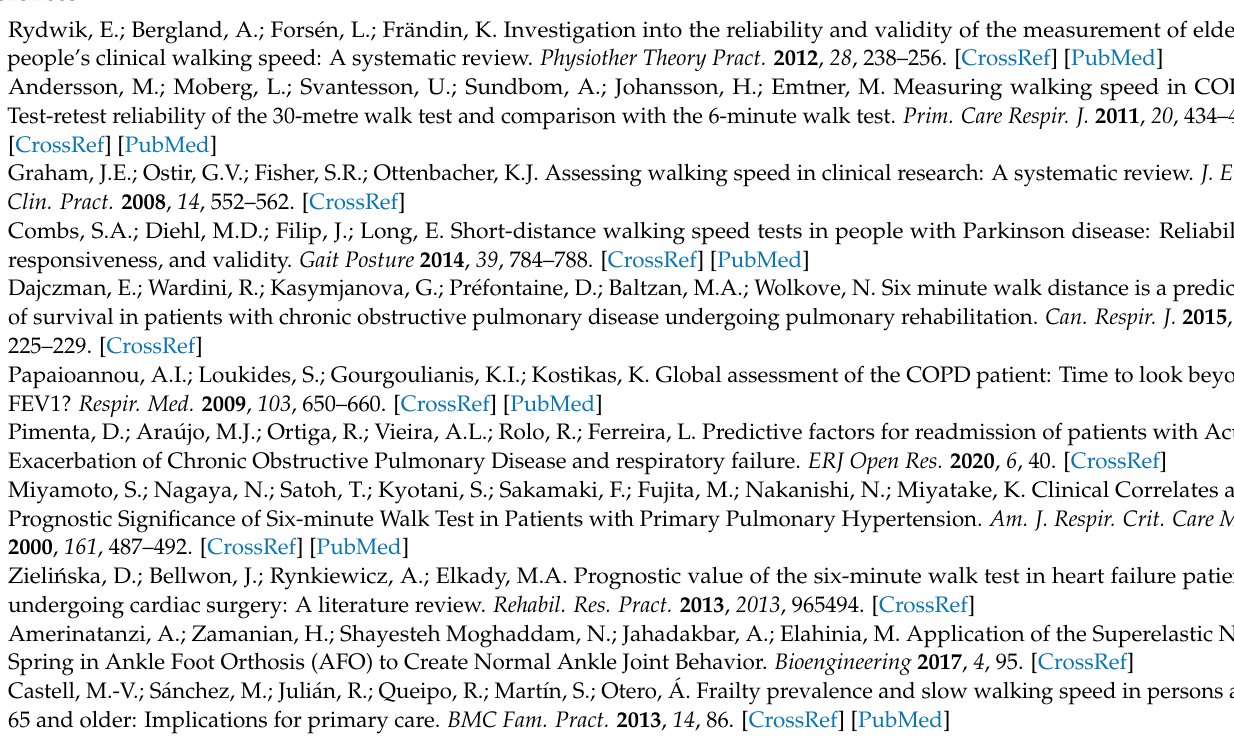
Figure A4. Scatter and bland-Altman plot of MOCAP vs. LEGSYS for right and left swing phase (%). Part A and B shows the scatter plot and bland-Altman plot on the left and right, respectfully for each parameter. For the scatter plot, the blue dots show right and left swing for each system. The bland-Altman plots show the difference between the MOCAP and LEGSYS parameters on the Y axis and MOCAP right and left swing. Blue line and dotted blue line show the bias and limits of agreement respectfully. The orange line on all 4 plots shows the least squares regression lines with orange dots being the 95% confidence interval.